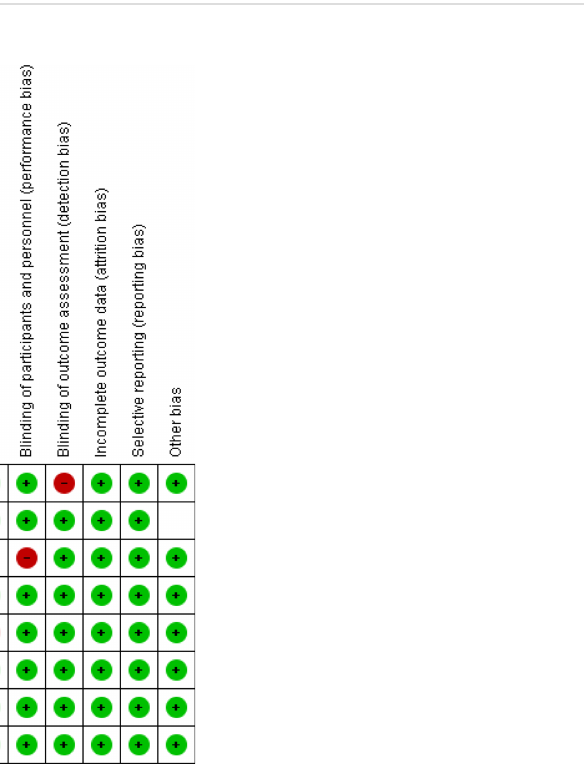
FIGURE 8 Risk of bias summary: Review authors ’ judgements about each risk of Bias item for each included